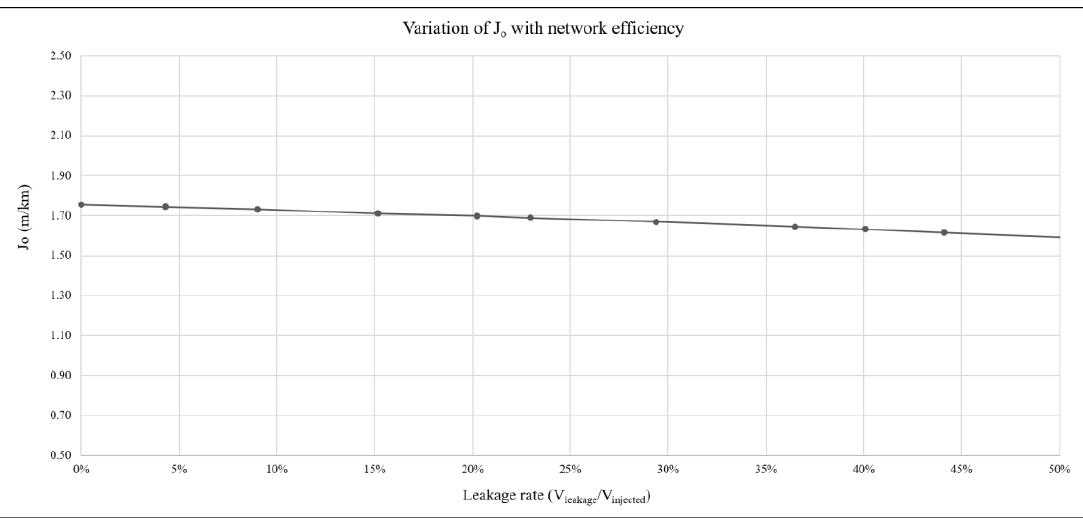
Figure 11. Variation in J 0 with average pumping station efficiency (case 1, steady network). A discussion of the potential error in the ELF value is relevant because the pumping station costs were not included in the CAPEX costs. Two factors provide the answer. The first is the impact of friction losses in the total head pump: if this value is moderate because the energy needs are led by service pressure requirements and elevation, the pumping station costs, even in consideration of their shorter life span of around 15 years, are practically friction independent and therefore do not influence J 0 . Secondly, if the cost of the pumping station is a small percentage of the total cost of the network, the effect is also minimal. Currently, in urban or irrigation networks, this may account for 5% of the total costs. Therefore, we conclude that including pumping costs in the CAPEX is not necessary. Perhaps this would not be the case with a closed industrial water circuit.